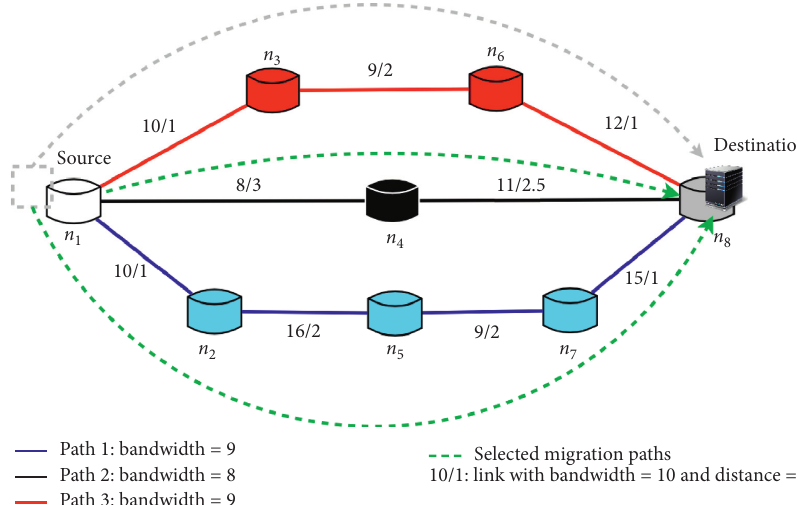
Figure 6: Best replacement paths selection for paths with equal bandwidths.